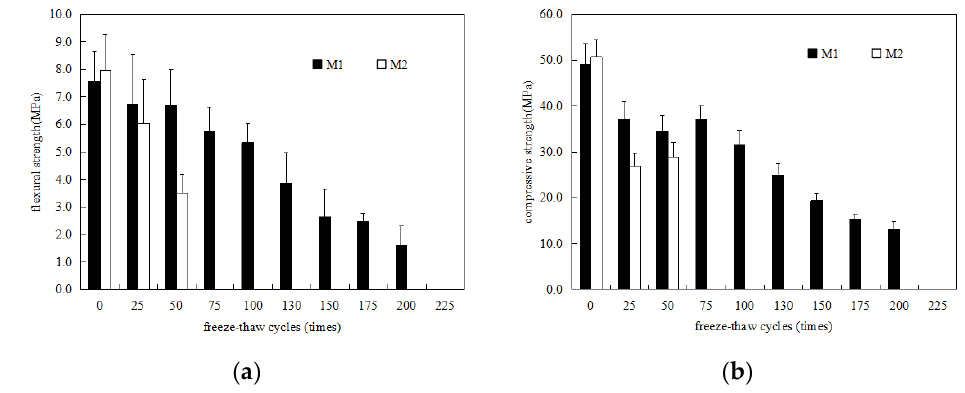
Figure 1. Strength changes in MKPC mortar specimens and P.O mortar specimens in a water-freeze– thaw environment. ( a ) Flexural strength; ( b ) compressive strength. thaw environment. ( a ) Flexural strength; ( b ) compressive